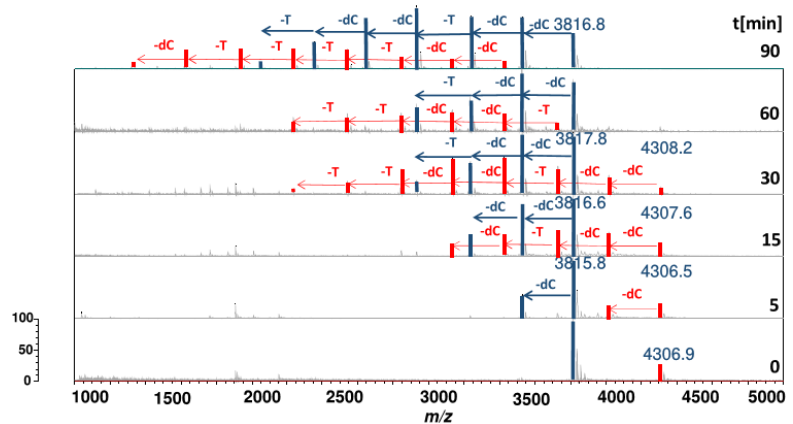
Figure 5. MALDI-TOF MS spectra of the hydrolysates obtained after the treatment of the equimolar mixture of oligonucleotides 1 (blue peaks) and 1a (red peaks) with svPDE. Spectra of aliquots taken at 0, 5, 15, 30, 60 and 90 min were acquired.